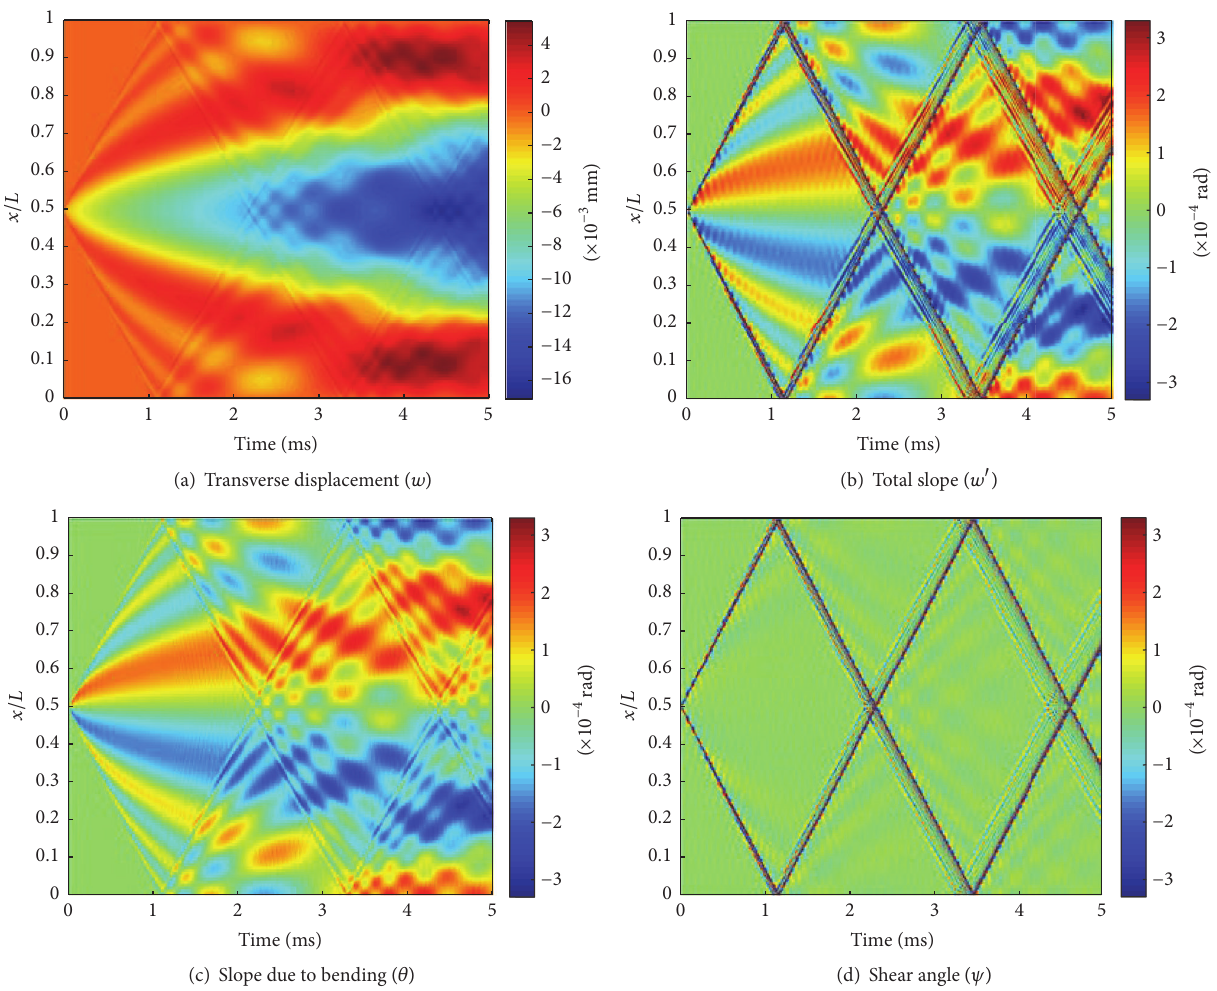
Figure 3: Wave propagations in a simply supported beam subjected to a stationary impulsive point transverse force applied at 𝑥/𝐿 = 0.5 : (a) transverse displacement (𝑤) ; (b) total slope (𝑤 󸀠 ) ; (c) slope due to bending (𝜃) ; (d) shear angle (𝜓)